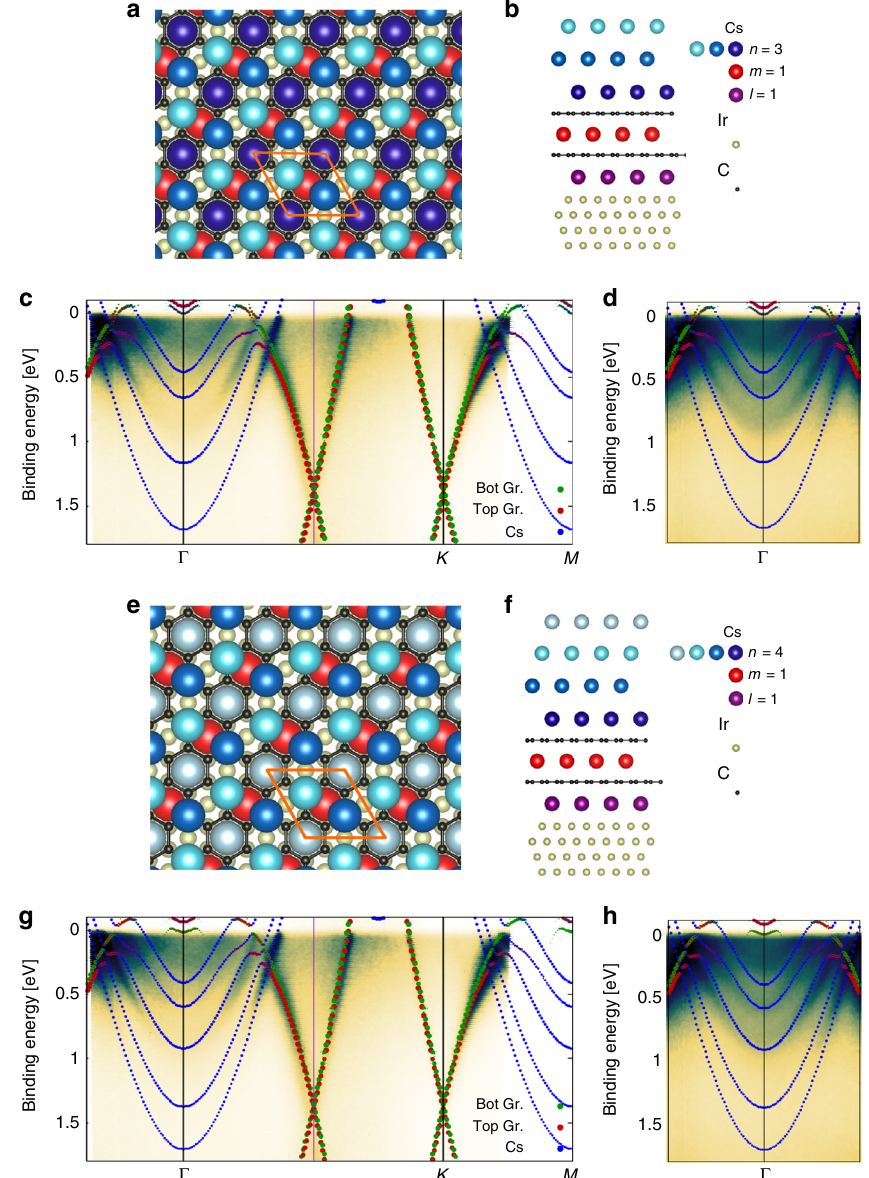
Fig. 3 Comparison of band structure calculations to ARPES experiment. a , b ℓ mn = 113 structural model viewed from top and from the side. The unit cell is indicated by an orange rhombus in a . c ARPES data overlaid by the DFT calculations of the 113 structure shown in a , b . d Region of the quantum well states overlaid with the calculation with a modi fi ed color scale to c . e , f ℓ mn = 114 structural model viewed from top and from the side. g , h like in c , d but for ℓ mn =